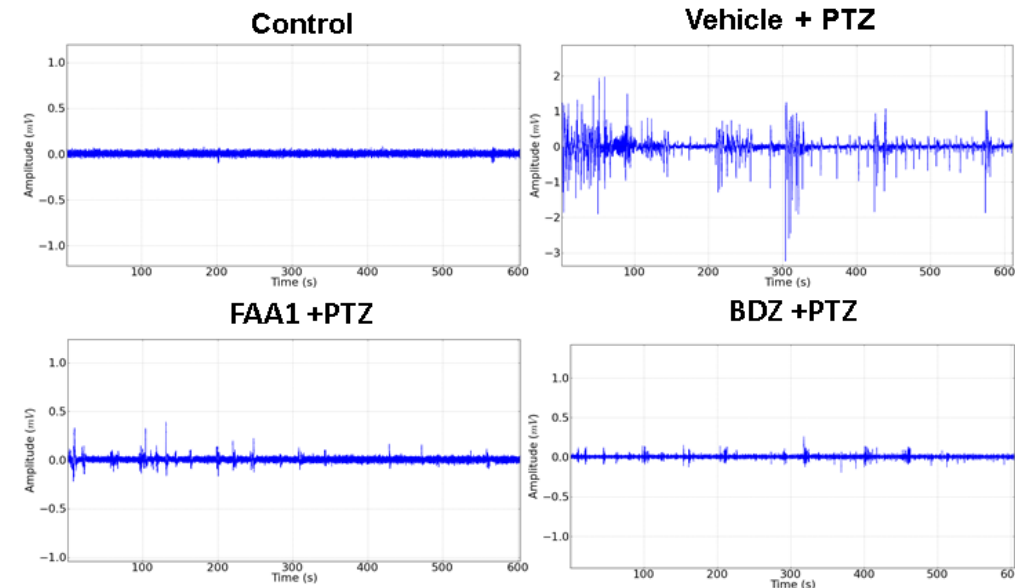
Figure 6. Electrocorticographic tracing of animals in the control group compared to the other groups treated with the vehicle, FAA1 (300 mg/kg), and BDZ (5 mg/kg), after PTZ (60 mg/kg) administration for 600 s.